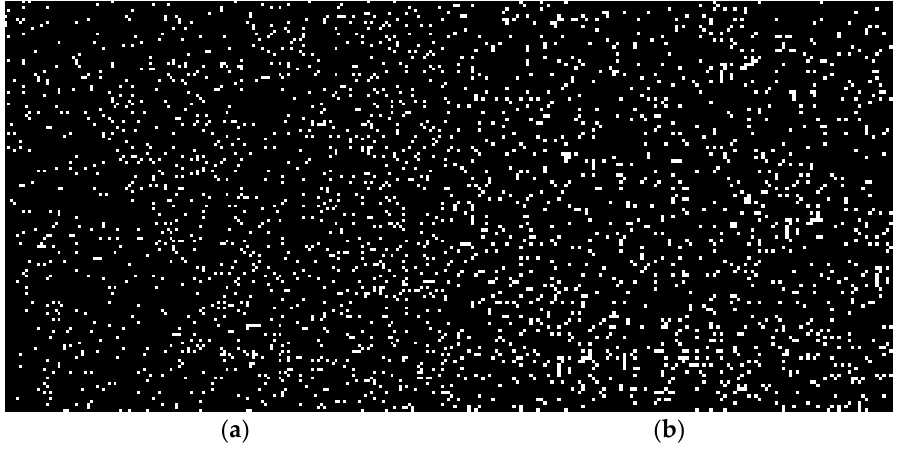
Figure 11. Distribution of Cu in the weld zone of ( a ) autogenous laser welding; and ( b ) PCALW.